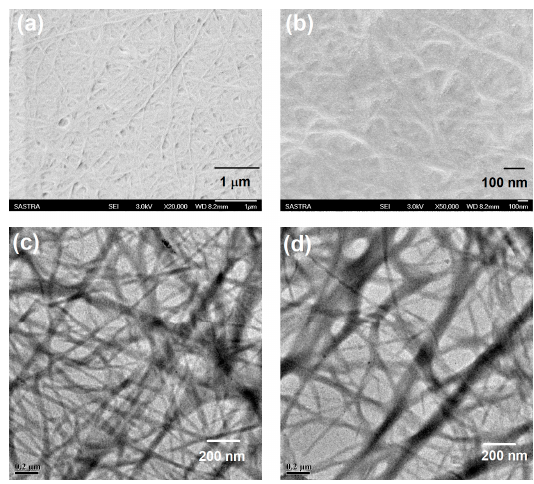
Figure 2. ( a and b ) Field Emission Scanning Electron Microscope (FESEM) image ( c and d ) and Field Emission Transmission Electron Microscope (FETEM) image of gel prepared from compound 5b in water-ethanol (1:5).